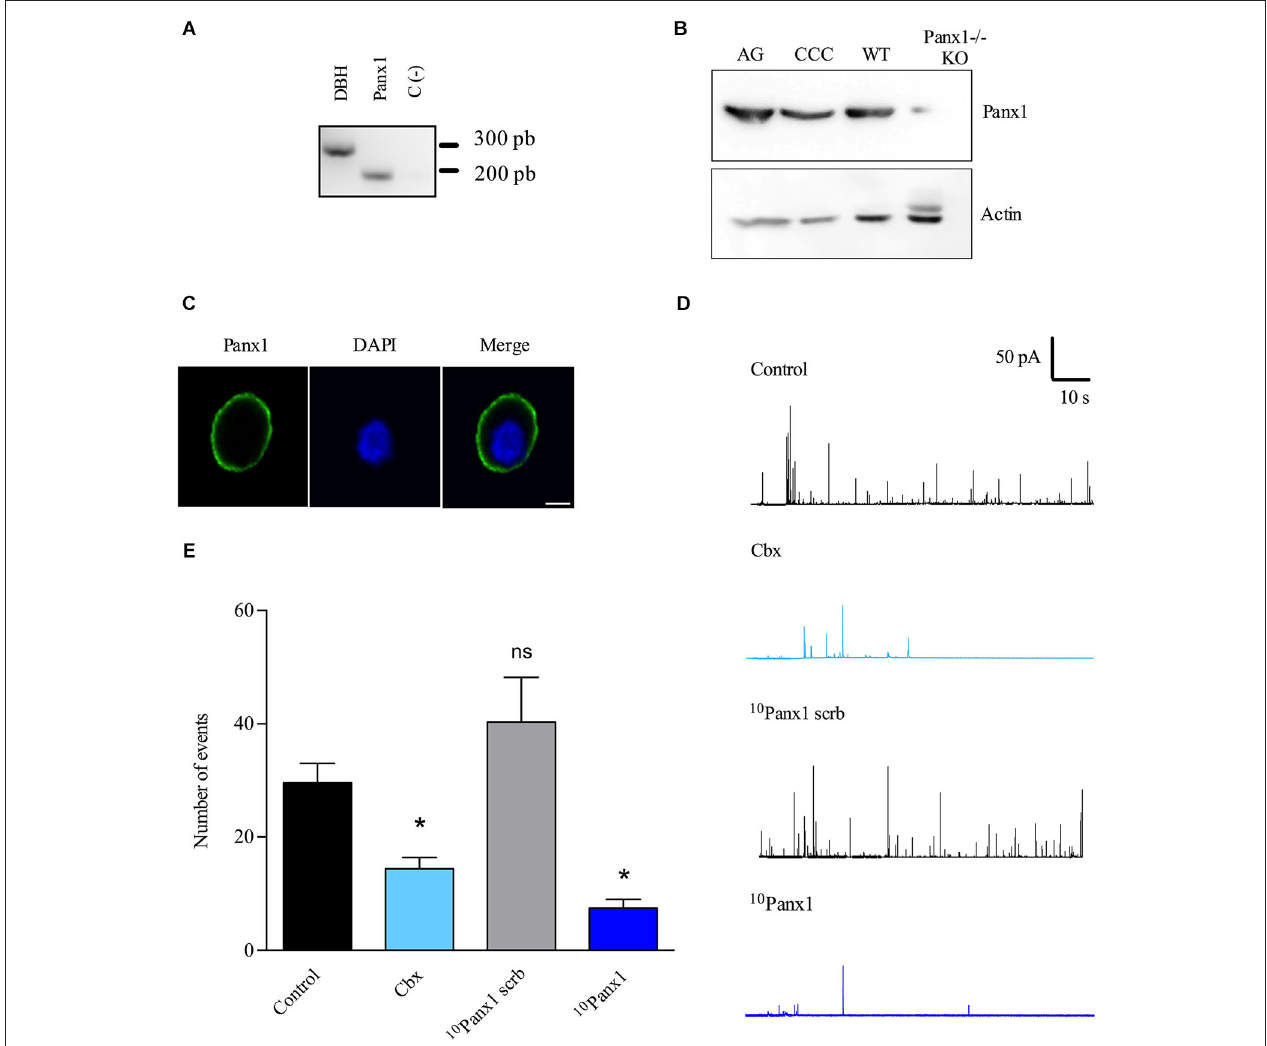
chromaffin cells with a polyclonal anti-Panx1 serum and visualized with an α -CY2-conjugated secondary antibody. Nuclei were visualized with DAPI staining. Scale bar = 10 µ m. (D,E) The secretory activity was evoked by a 10 s pulse of the nicotinic agonist DMPP (50 µ M) and monitored by amperometry. Cells were pre-incubated with the different inhibitors during 15 min at 37 ◦ C, which were maintained in the bath solution during the whole experiment. (D) Representative amperometry traces from control cells or cells treated with Cbx (5 µ M), 10 Panx1 scrb peptide (200 µ M) or 10 Panx1 peptide (200 µ M). Note that Panx1 channel inhibitors decreased the number of exocytotic events. (E) Data show average values ± SEM of the number of events during 100 s recording of control cells ( n = 55), or cells treated with Cbx ( n = 20), 10 Panx1 scrb peptide ( n = 18) or 10 Panx1 peptide ( n = 25) from three to five different cultures. ns = non-significant, * p < 0.05 (Krukal-Wallis test) compre with control cells.